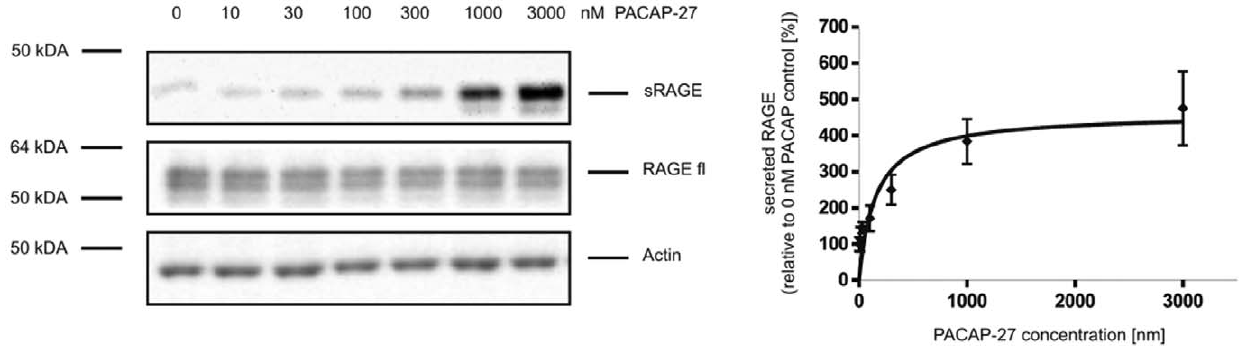
Figure 4. PACAP-induced dose-dependent shedding of RAGE. PAC1/RAGE cells were treated for 4 h with increasing PACAP-27 concentrations (ranging from 10 nM up to 3000 nM). Afterwards the medium was collected and sRAGE was identified with the Ab3260 as described in Figure 1. For quantification, the experiments were done in triplicates. Shown are the mean effects 6 S.D. Full-length RAGE and actin were detected in total cell lysates by Western blot